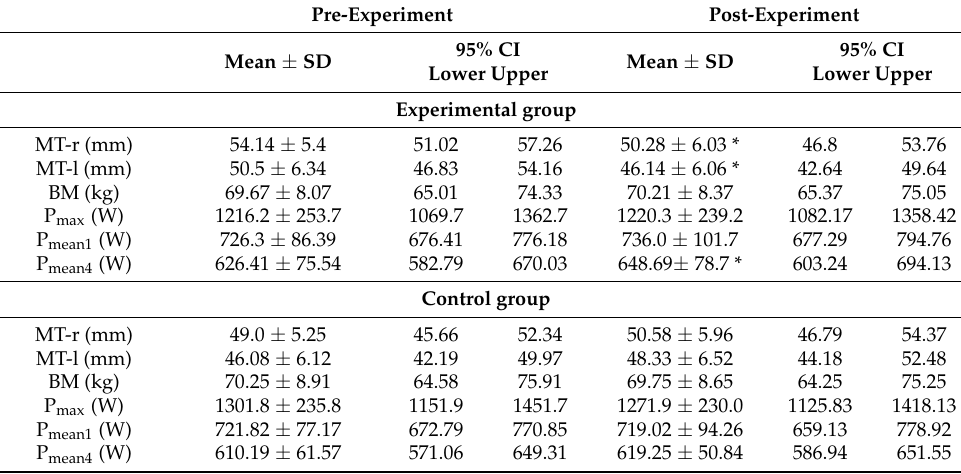
Table 2. Pre- and post-experiment muscle thickness and anaerobic power